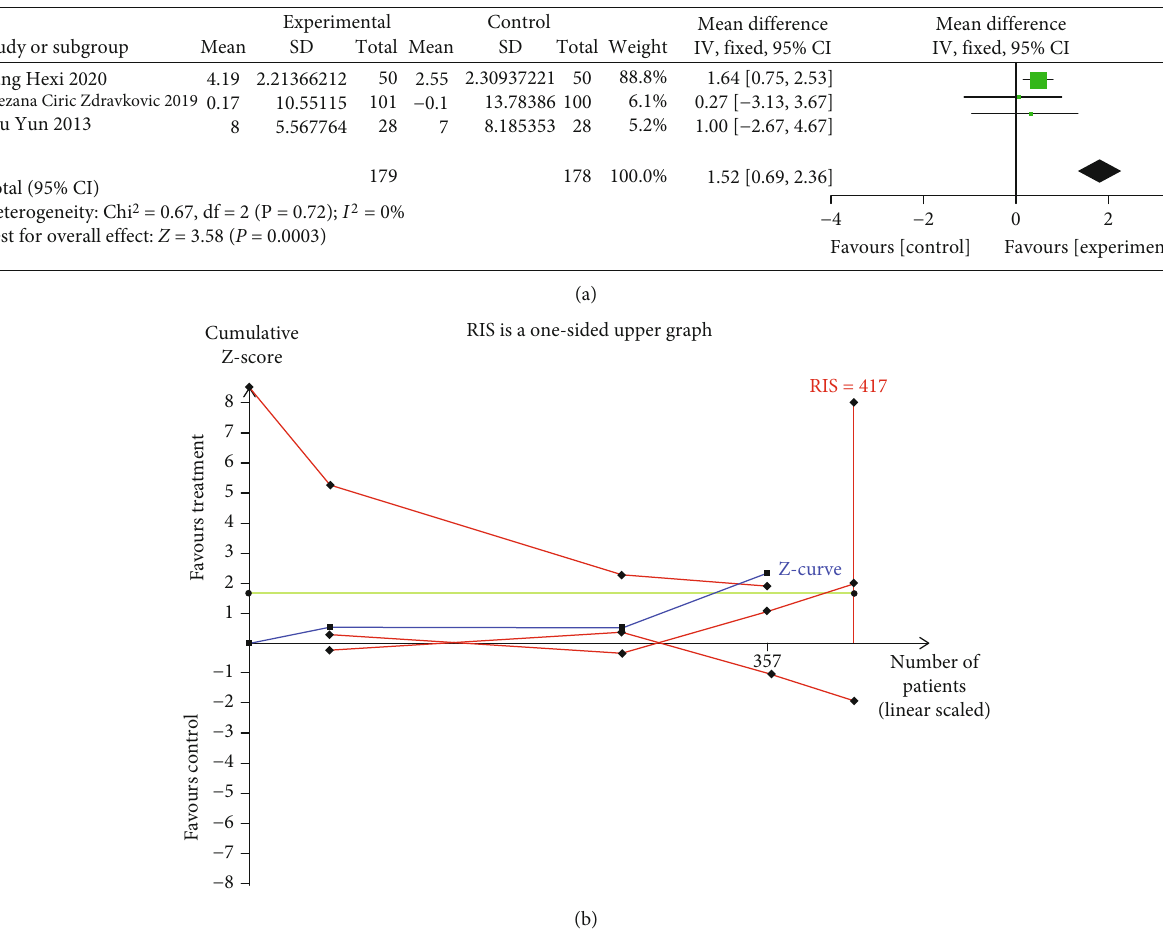
Figure 4: (a) Forest plots of the e ff ect of oral iron on LVEF; (b) trial sequential analysis of